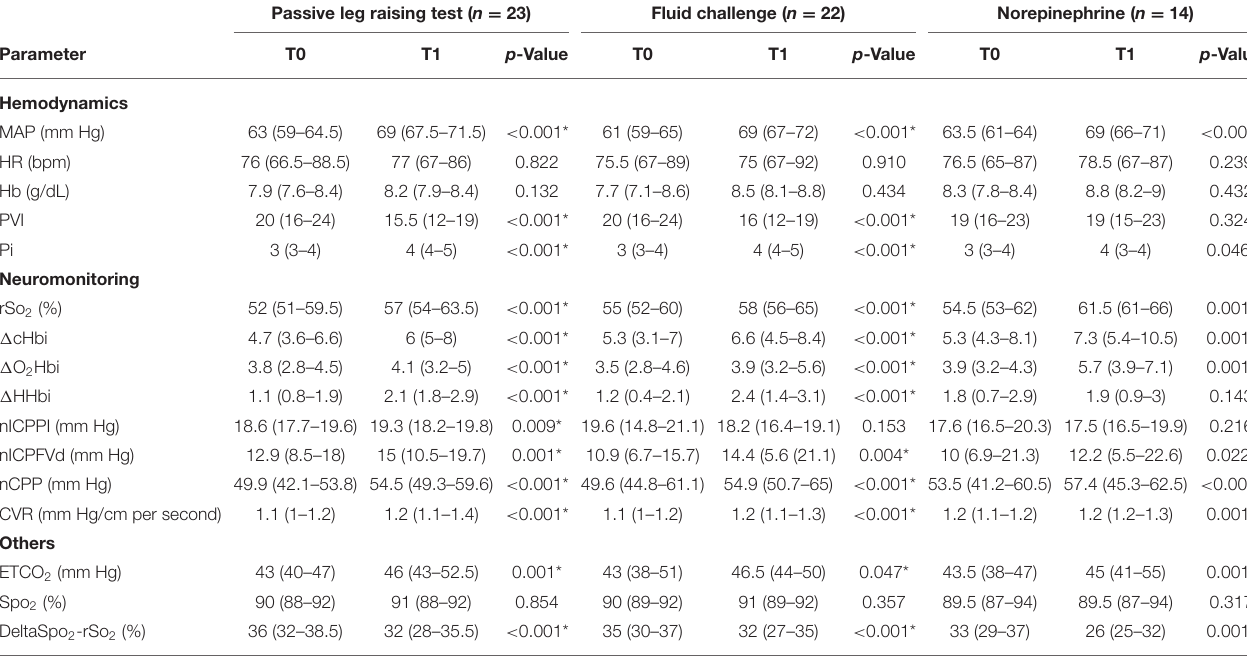
TABLE 2 | Hemodynamic and neuromonitoring variables before (T0) and after (T1) passive leg raising test, fluid challenge, and norepinephrine. Passive leg raising test ( n = 23) Fluid challenge ( n = 22) Norepinephrine ( n = 14)